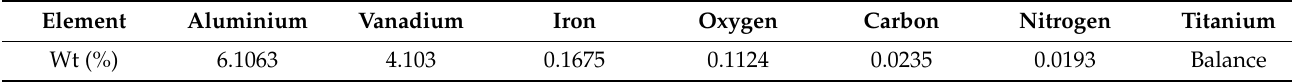
Table 1. Composition (Wt%) of Ti-6Al-4V alloy [20].